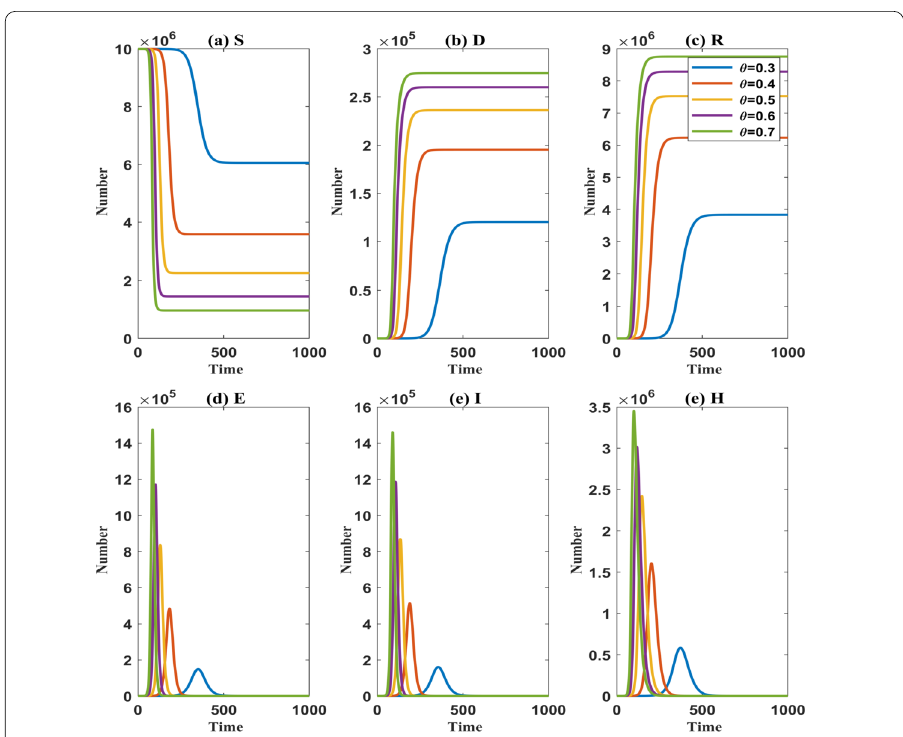
Figure 2 The evolution of the susceptible population ( S ), the exported population ( E ), the symptomatic infected population ( I ), the hospitalized population ( H ), the recovered population ( R ), and the death population ( D ) over time under θ = 0.3,0.4,0.5,0.6,0.7. ( a ): the number of S ; ( b ): the number of D ; ( c ): the number of R ; ( d ): the number of E ; ( e ): the number of I ; ( f ): the number of